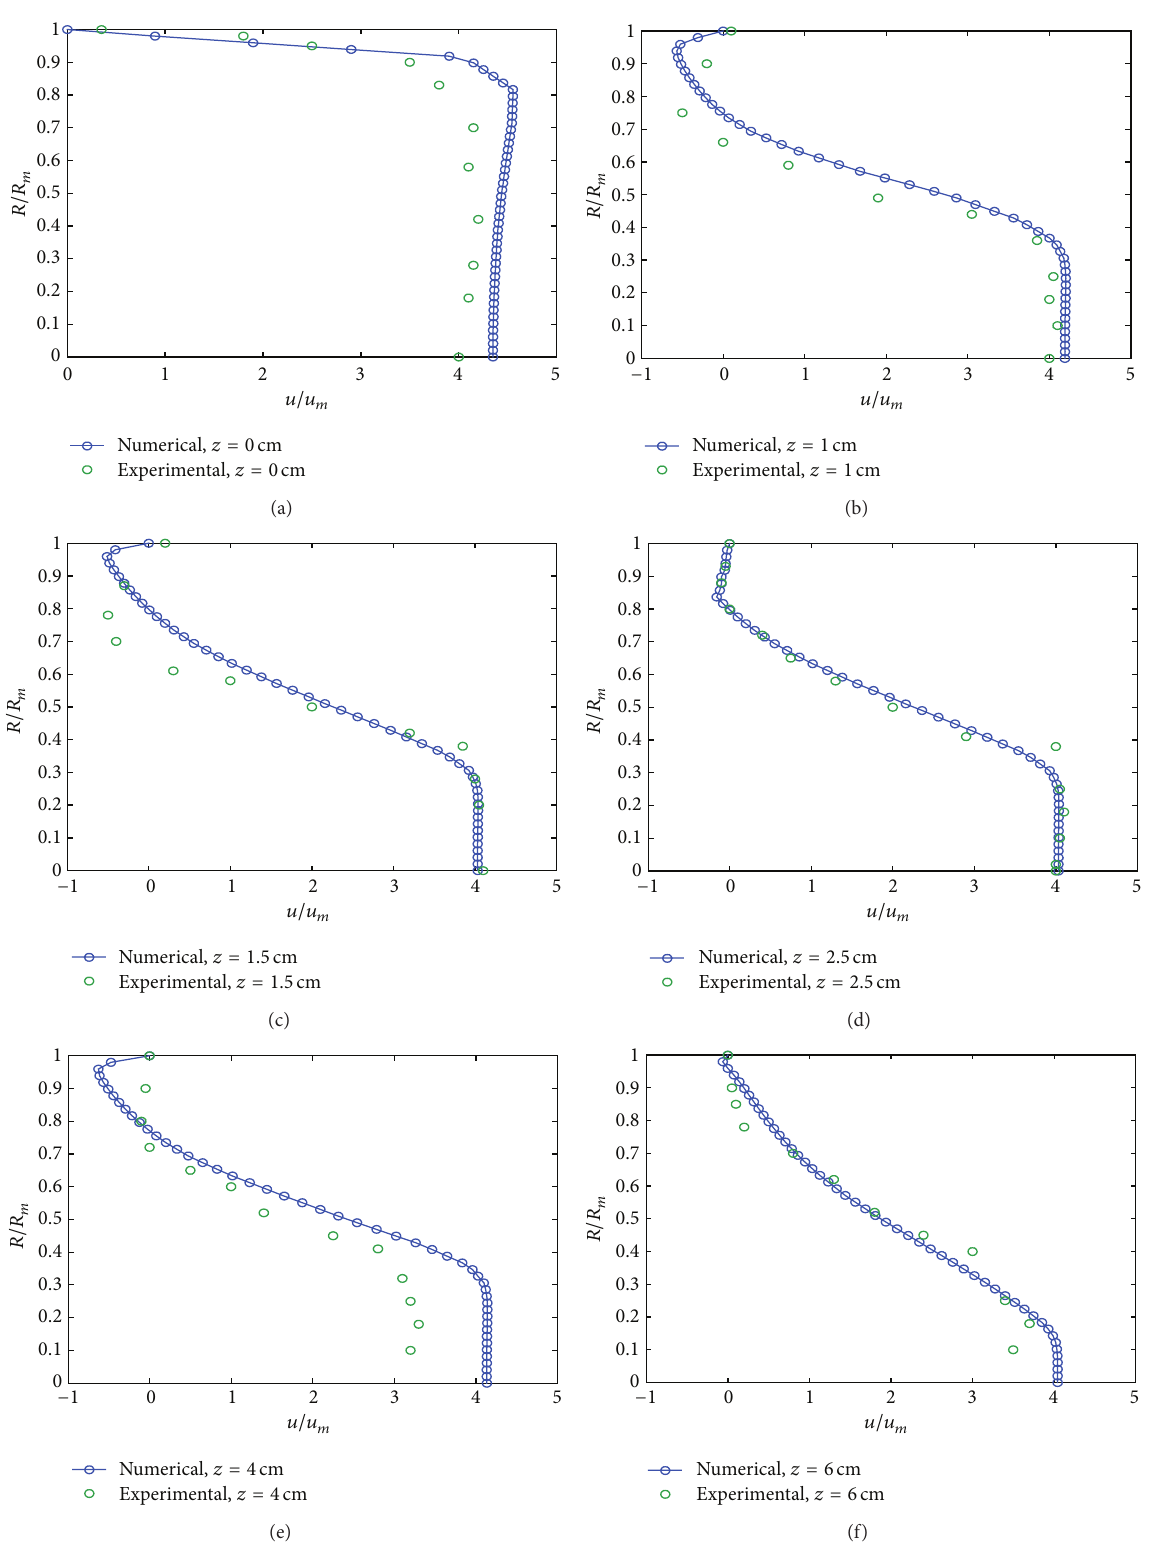
Figure 5: Axial velocity profiles of the idealized stenosed tube at different axial positions: (a) 𝑧 = 0 cm, (b) 𝑧 = 1 cm, (c) 𝑧 = 1.5 cm, (d) 𝑧 = 2.5 cm, (e) 𝑧 = 4 cm, and (f) 𝑧 = 6 cm at peak velocity. The experimental results from Ahmed and Giddens [26] are shown for